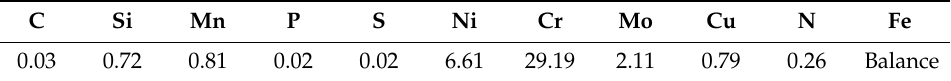
Table 1. Chemical compositions of SAF2906 DSS sample (wt